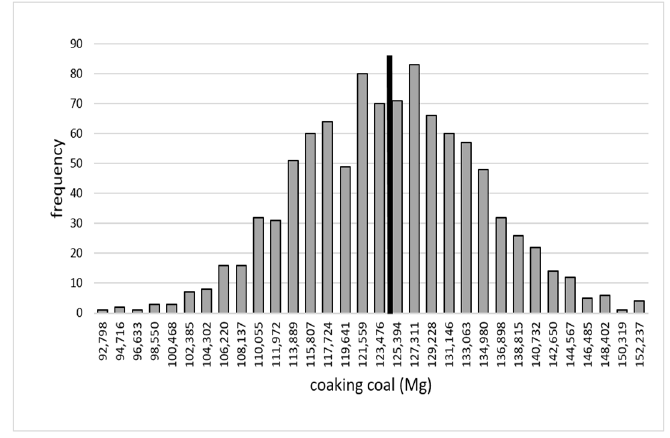
Figure A5. Histogram showing frequencies of achieving given quantity of sales of coking coal (“Export 5”) for mine “C” with σ yprog .